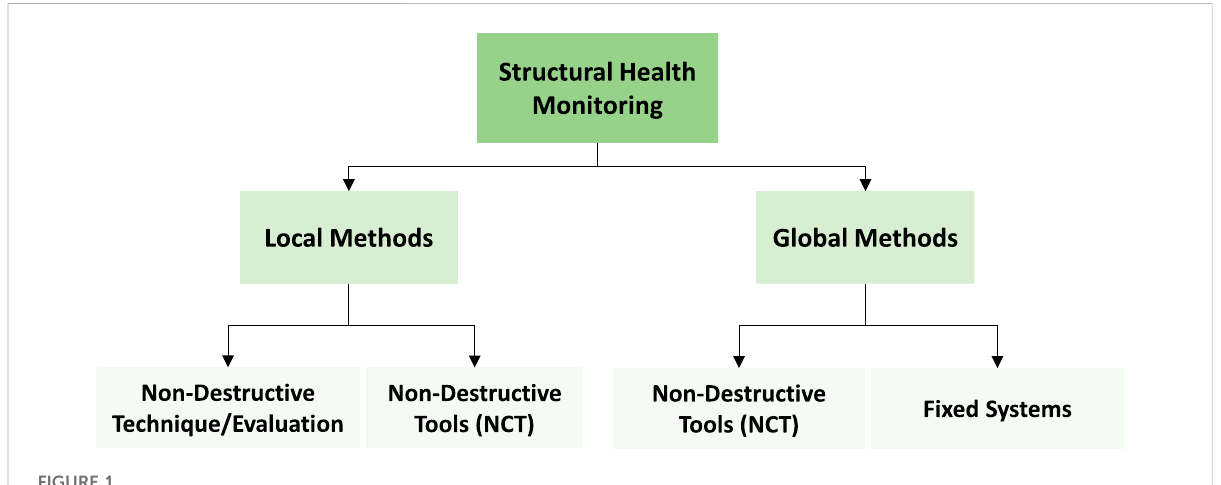
FIGURE 1 Structural Health Monitoring considering their application